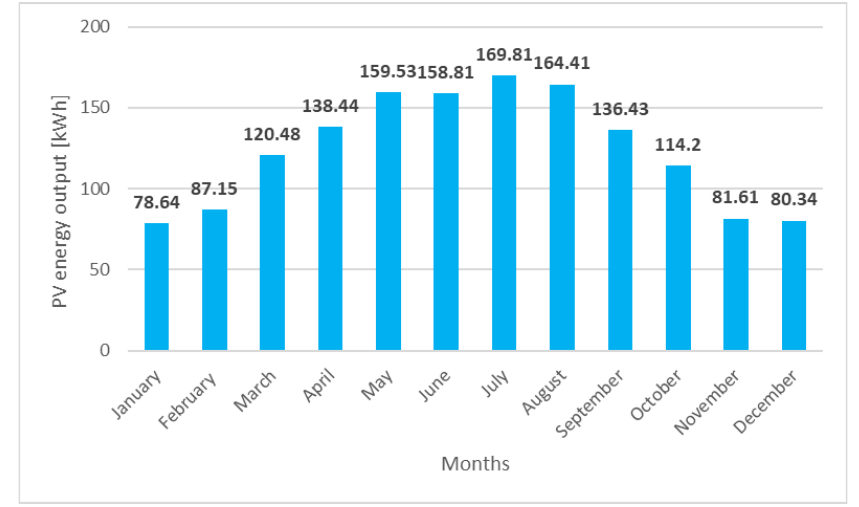
Figure 5. Monthly energy output from a fixed-angle PV system in Procida [33].